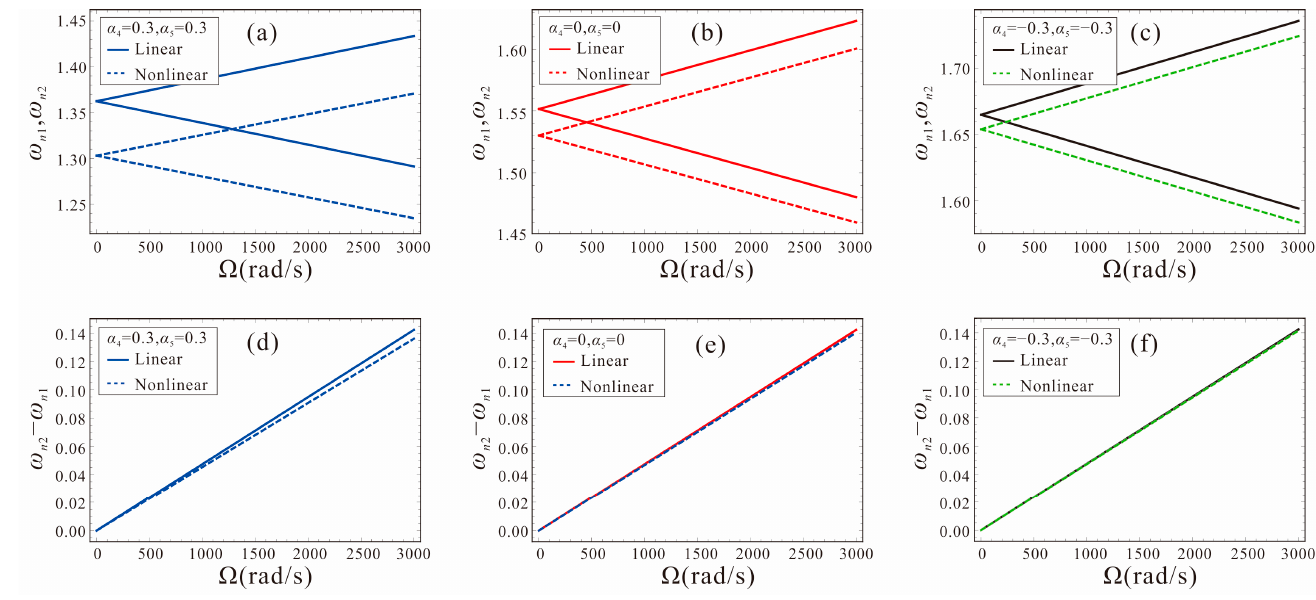
Figure 14. Linear frequency and nonlinear frequency variation curves of micro-gyroscope for different shape factors. ( a,d ): shape factors are α 4 = α 5 = 0.3; ( b,e ): shape factors are α 4 = α 5 = 0; ( c,f ): shape factors are α 4 = α 5 = − 0.3.